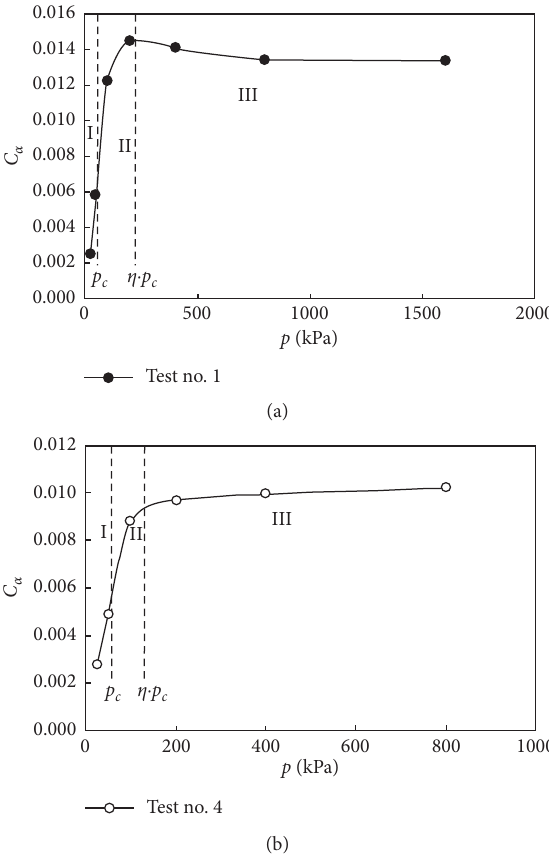
Figure 7: The relationship between the secondary consolidation coefficient and the consolidation pressure for (a) test no. 1 and (b) test no. 4.